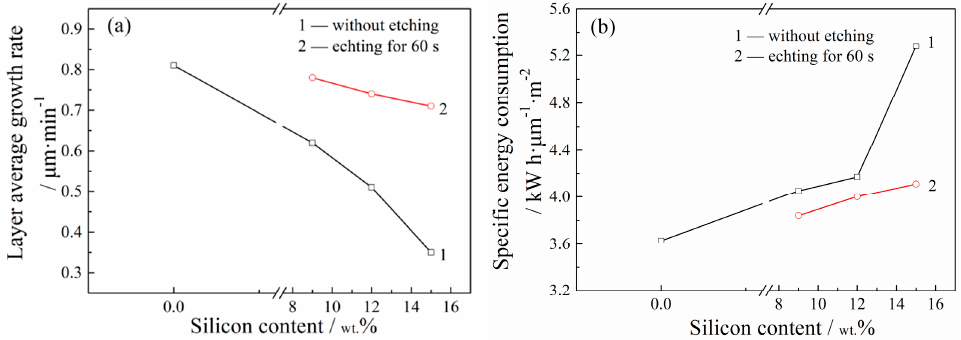
Figure 12. Average growth rate ( a ) and specific energy consumption ( b ) of different Al-Si alloys by 10 min. of MAO treatment.